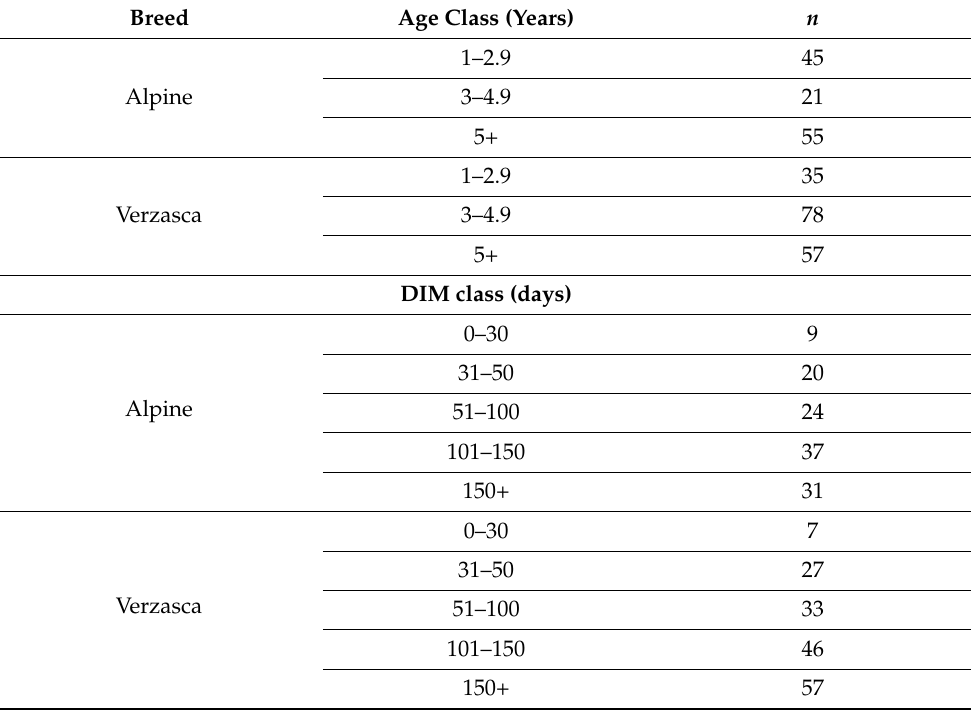
Table 1. Sample distributions for breed, age class and days in milk class (DIM class) for the en- rolled goats.